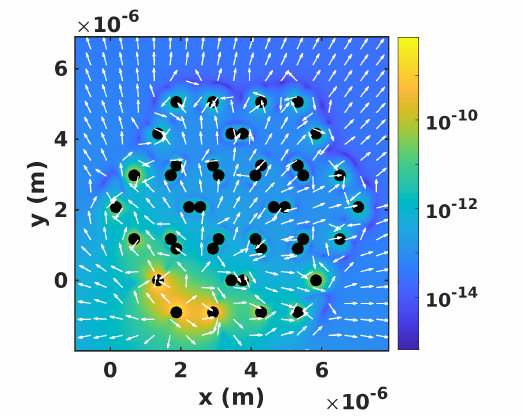
Figure 2. Spectral mean Poynting vector at the edge mode fre- quency in a honeycomb lattice of InSb nanoparticles where the particle at the lower left is heated with respect to the other parti- cles.